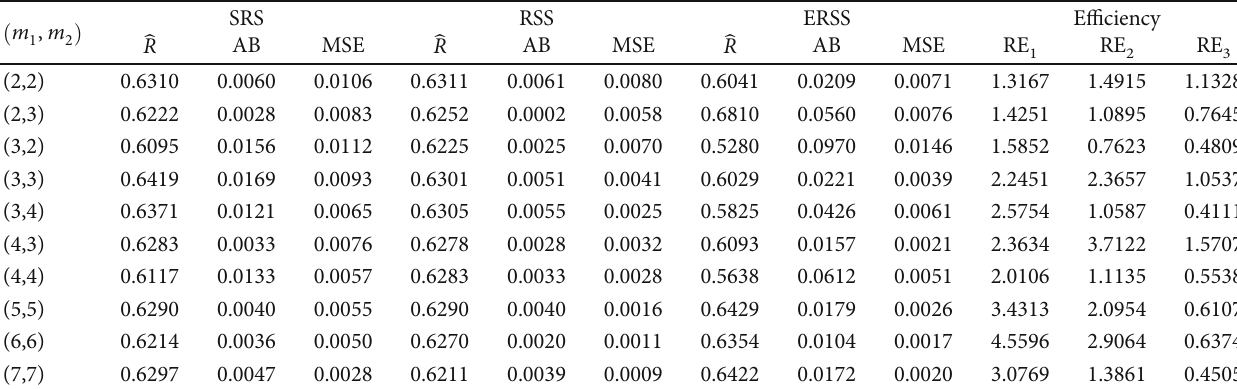
Table 6: Measures of ̂ R for di ff erent sampling schemes at R = 0 : 625 .